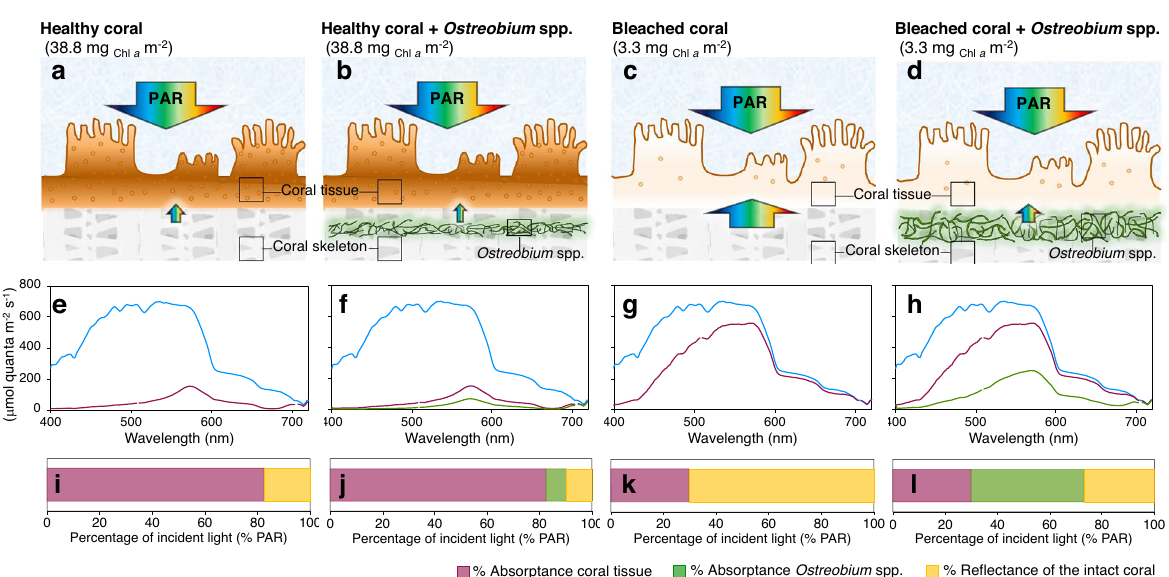
% Absorptance Ostreobium spp. Figure 5. Numerical model for light transmission in corals. Light transmission simulation for a coral at 5 m depth was calculated for: ( a ) a healthy phenotype (38.8 mg Chl a m −2 ) with a white coral skeleton; ( b ) a healthy phenotype (38.8 mg Chl a m −2 ) with a coral skeleton colonized by the endolithic algae Ostreobium spp.; ( c ) a bleached phenotype (3.3 mg Chl a m −2 ) with a white coral skeleton; and ( d ) a bleached phenotype (3.3 mg Chl a m −2 ) with a coral skeleton colonized by Ostreobium spp. Plots ( e–h ) describe changes in the light absorption spectra along the PAR range (400–720 nm) after penetrating 5 m depth into the water column (light blue solid line), and after crossing different layers into the coral structure, which comprises: the coral tissue layer (pink solid line), and the Ostreobium spp. algae layer located 0.1 mm below the coral tissue (green solid line); under different scenarios: plots ( e , f ) represent a healthy coral with out and with Ostreobium spp. in the coral skeleton surface; plots ( g , h) represent a bleached coral with out and with a coral skeleton colonized by Ostreobium spp. Finally, plots ( i – l ) describe the percentage of PAR utilized by each layer inside coral: coral tissue (pink), Ostreobium spp. (green) and coral reflectance (yellow), under the 4 former